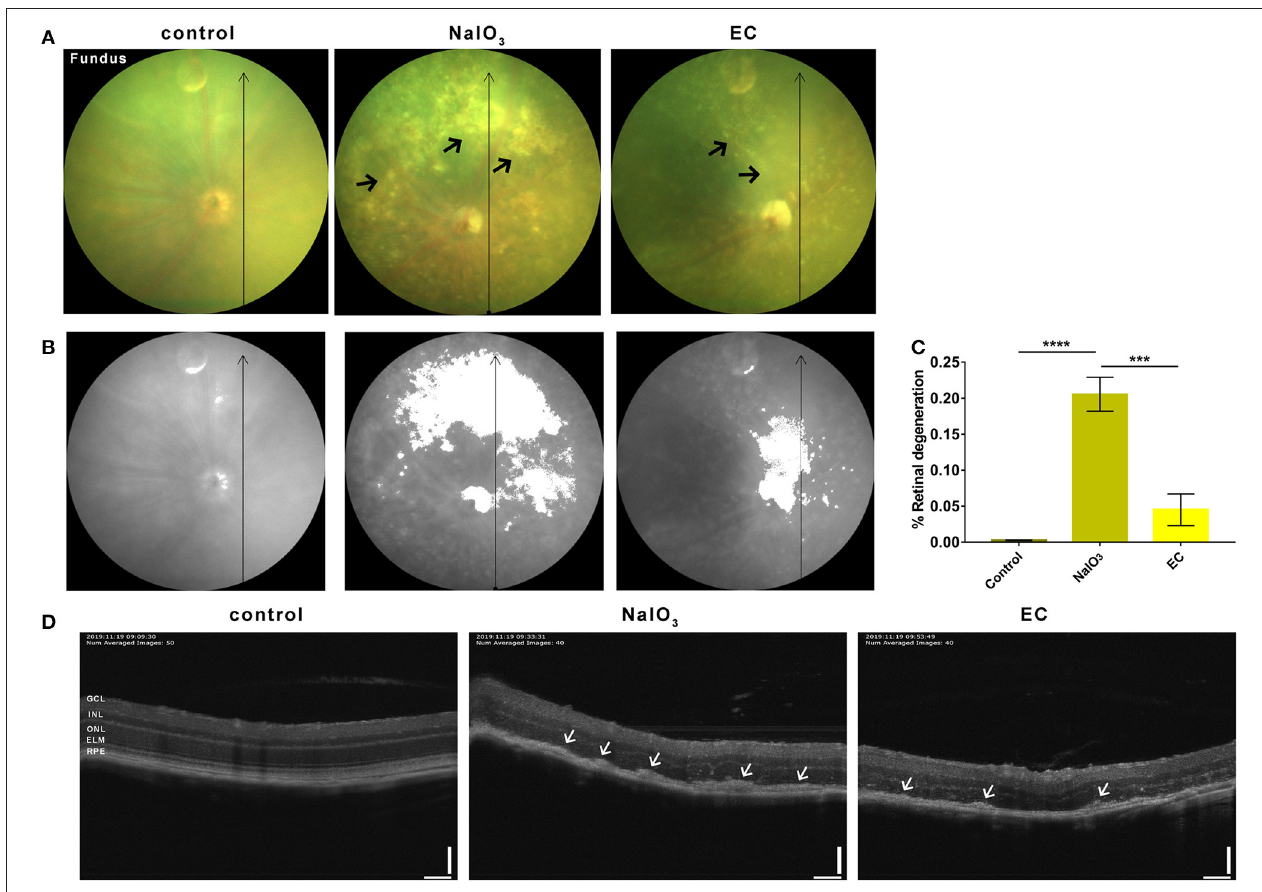
FIGURE 3 | EC reduced outer retinal degeneration induced by NaIO 3 administration. (A) Representative color fundus photographs taken at day 7 post-NaIO 3 administration showed that EC reduced the number of yellow-white deposits. Black arrows indicate drusen-like deposits. (B) Color fundus photographs were converted to gray scale with retinal degeneration areas show in white. (C) The percentage of retinal degeneration (degeneration area/total area) were quantified. (D) Representative OCT images showed EC reduced hyperreflective foci in the outer retinal layers. White arrows indicate high reflex lesions. GCL, Ganglion cell layer; INL, inner nuclear layer; ONL, outer nuclear layer; ELM, external limiting membrane; RPE, retinal pigment epithelium. Values are presented as mean with SEM; n = 4 or 5. *** p < 0.001, **** p < 0.0001; Scale bar: 50 µ